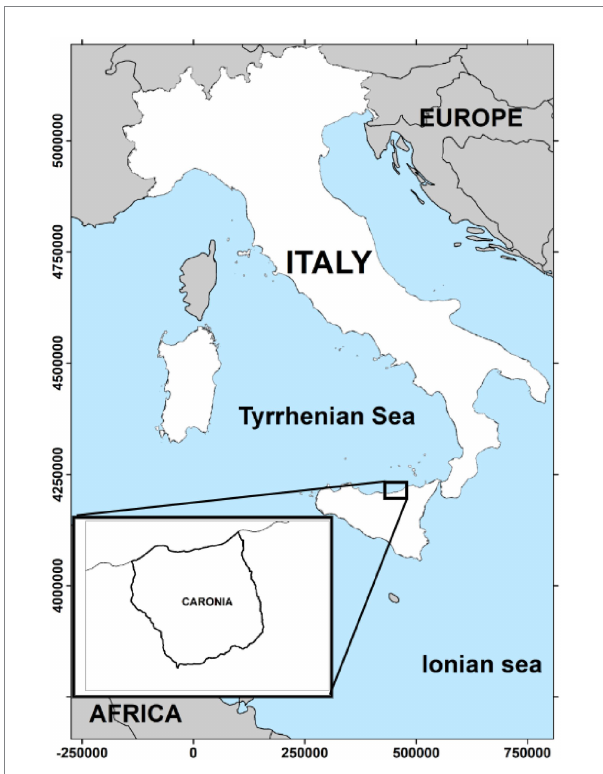
FIGURE 1 The geographical area under study. The district of Caronia covers 227.3 km 2 in the province of Messina on the northern coast of Sicily, Italy. The map was adapted from